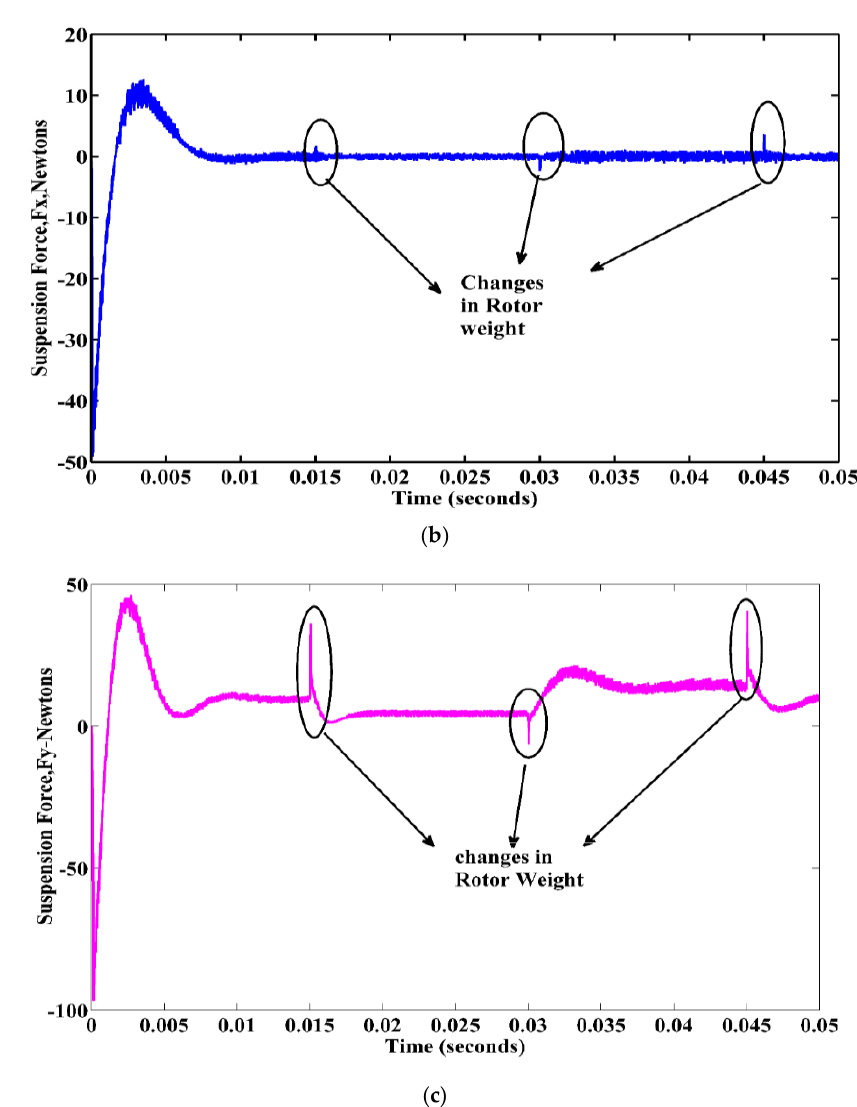
Figure 22. Suspension Parameters. ( a ) Rotor X- and Y-axis dispalcements when rotor weight is changed; ( b ) Suspension force in the X direction when rotor weight is changed; ( c ) Suspension force in the Y direction when rotor weight changed.